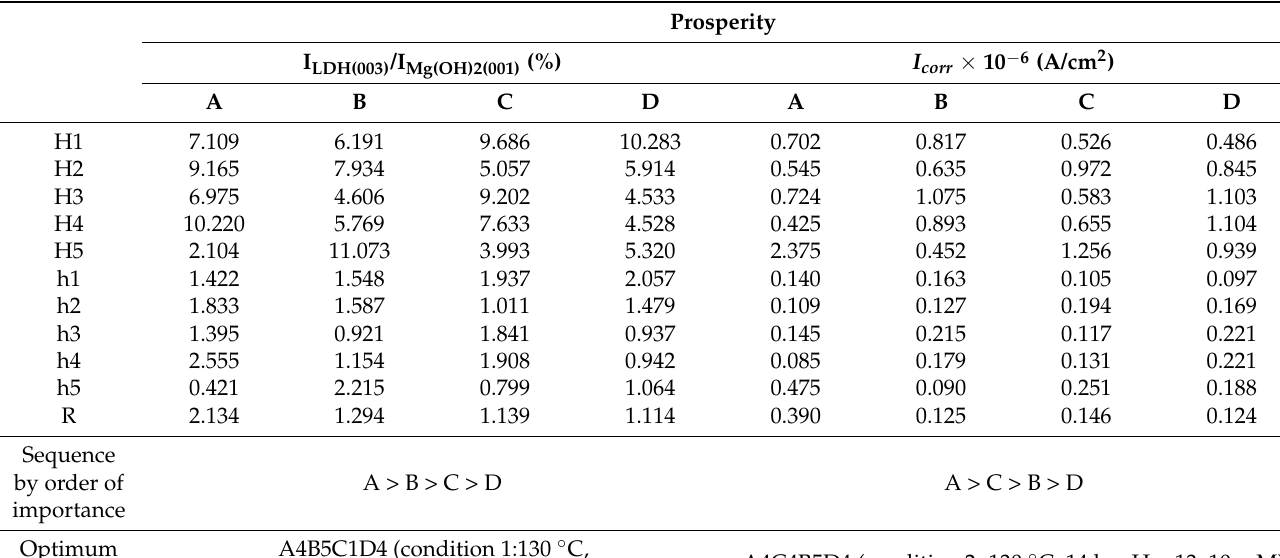
Table 3. Analysis of a range of orthogonal